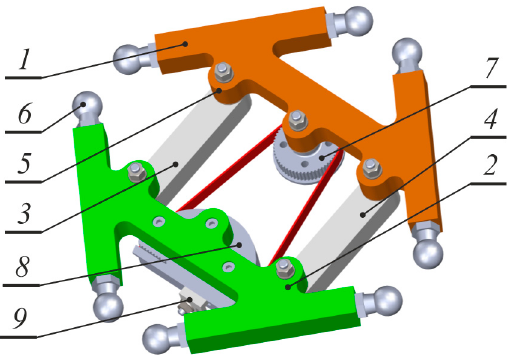
Figure 2. Operating platform of the designed manipulator. 1, 2—main elements; 3,